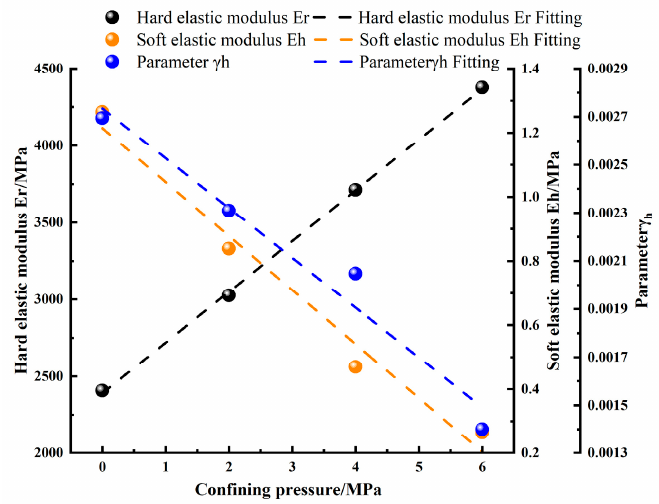
Figure 10. Relationship between model parameter solution and stress–strain curve.